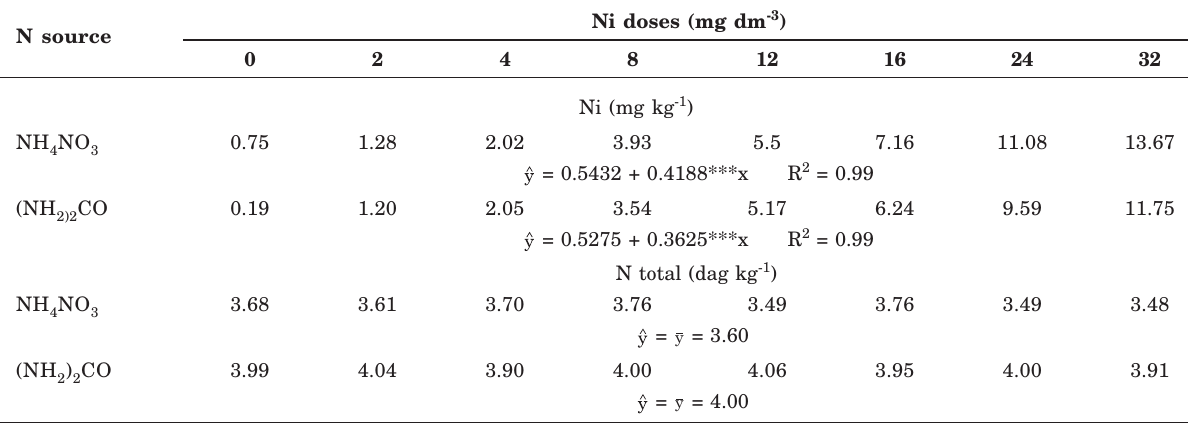
Table 2. Nickel (Ni) and nitrogen (N) concentrations in the dry matter of lettuce plants grown in soil amended with Ni doses and fertilized with two N sources. The regression equations for the dry-matter Ni and N are functions of the Ni doses applied to the N source